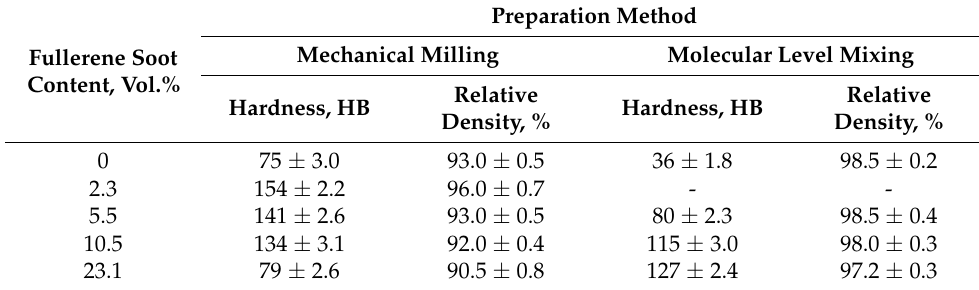
Table 1. Properties of the